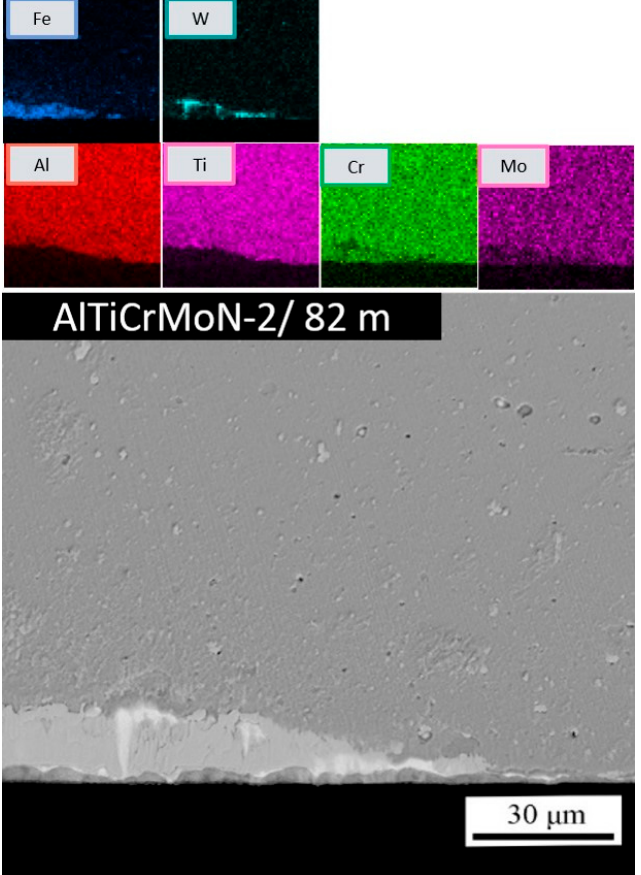
Figure 8. SEM image and EDS mapping results of the AlTiMoN-2 coated end mills after cutting length of 82 m. Table 4. Comparison of cutting performance of different coatings for machining austenitic stainless steels.